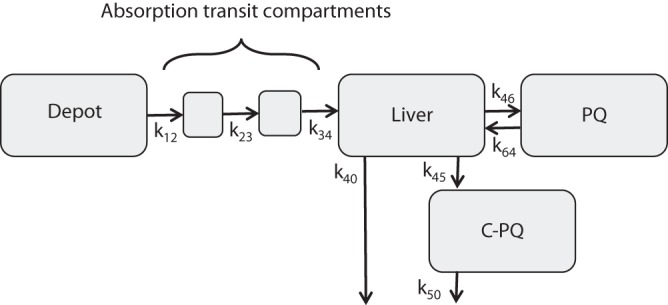
Schematic representation of the model. The mass transport of this model can be described with the following rate constants: k12 = 3/MAT, k23 = 3/MAT, k34 = 3/MAT, k40 = CLH,CYP2D6/VL, k45 = CLH,MAO/VL, k50 = CLCPQ/VCPQ, k46 = [QH (1 − EH)]/VL, and k64 = QH/VPQ.